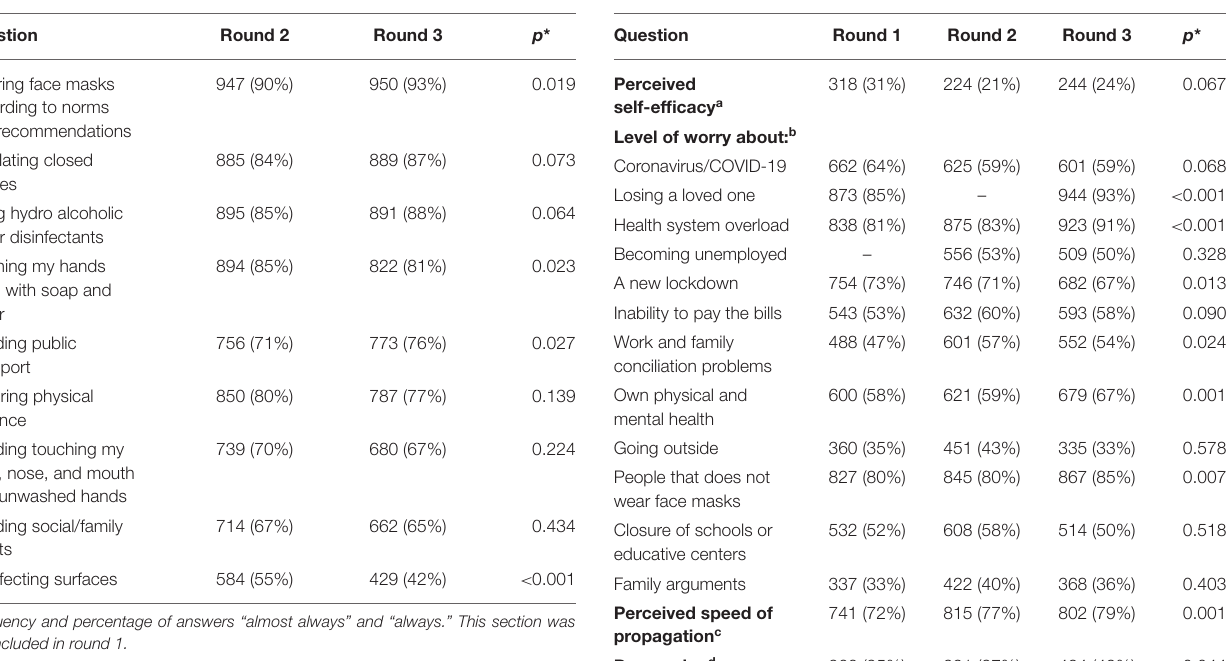
TABLE 4 | Use of preventive measures in each round.